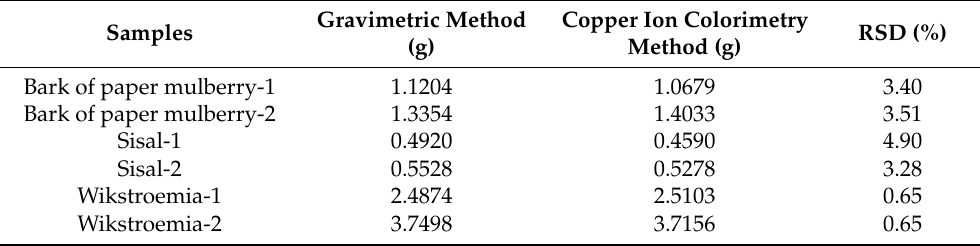
Table 4. Comparison of copper ion colorimetry method and gravimetric method for different pectin